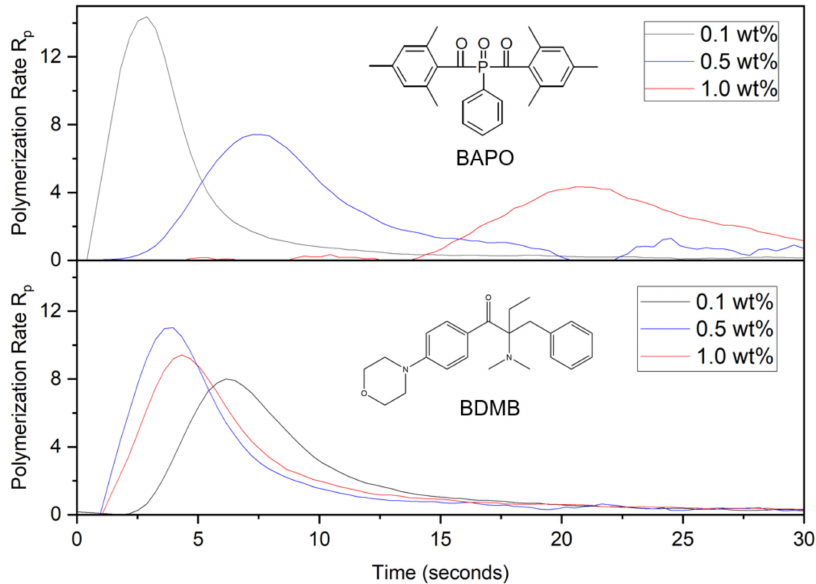
Figure 8. Polymerization rate, or change in DC per second, for BAPO and BDMB at various concen- trations, measured at a 3-mm depth under continuous irradiation of 380 mW/cm 2 UV